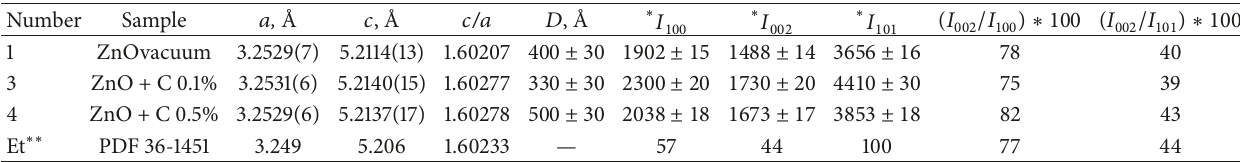
Table 2: Parameters of crystal lattices ( 𝑎 , 𝑐 ), the sizes of grains ( 𝐷 ), and the ratio of integrated intensity of the main diffraction peaks (100), (002), and (101) in wurtzite lattices of NPs pure and carbon-doped ZnO after